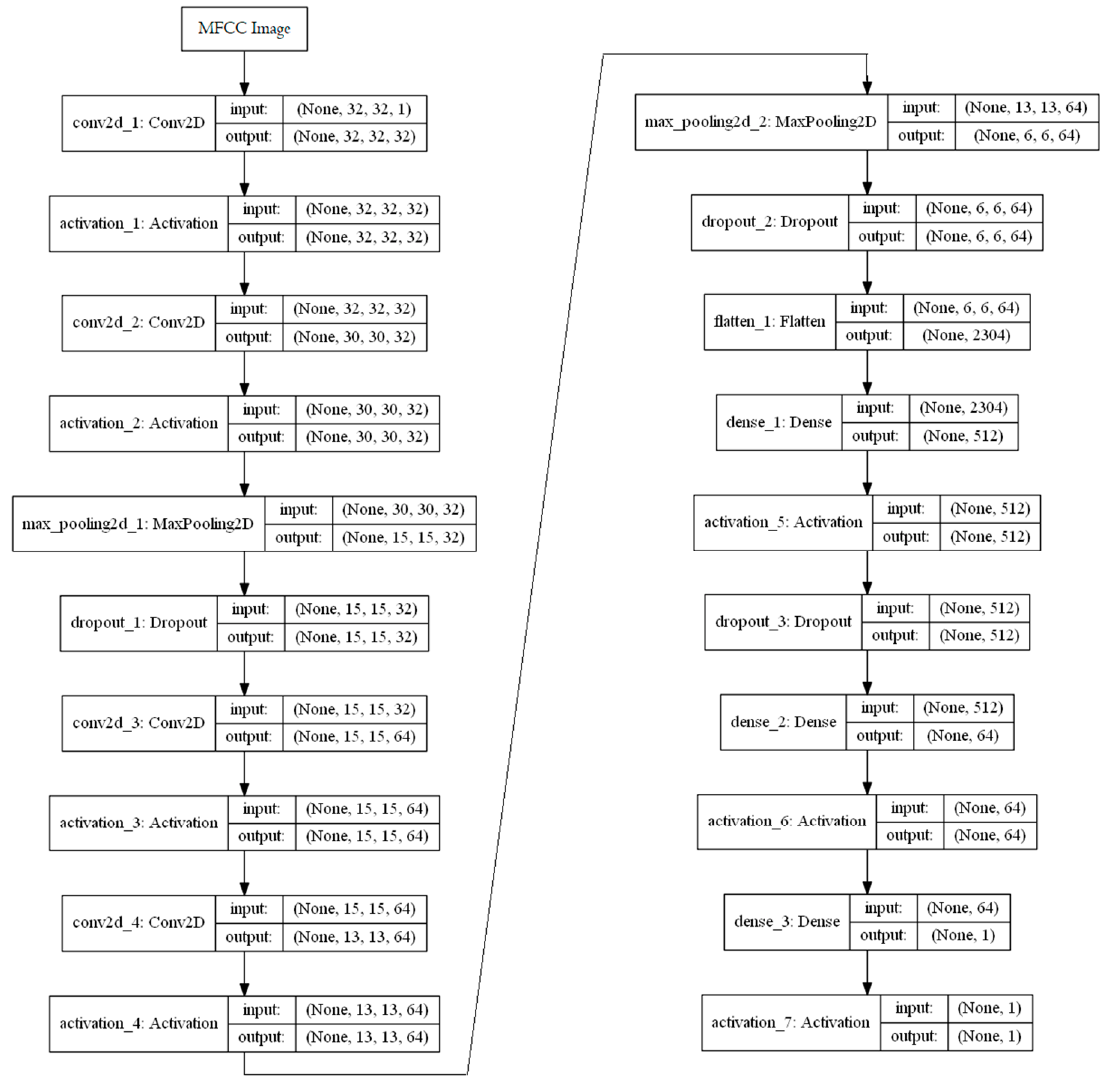
Figure 3. The proposed convolutional neural network architecture.